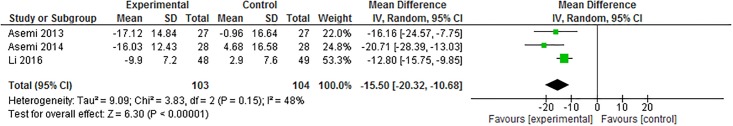
Meta-analysis of the decrease in fasting blood glucose at the end of the study.